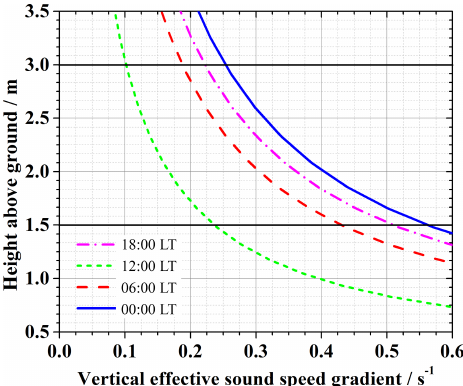
Figure 9. Vertical profiles of vertical effective sound speed gra- dient (30min mean) in sound propagation direction simulated by HIRVAC for homogeneous grassland (vegetation height = 0.3m; leaf area index = 2) on 15 July (example for a cloudless sum- mer day similar to experimental conditions) for different day times (LT = local